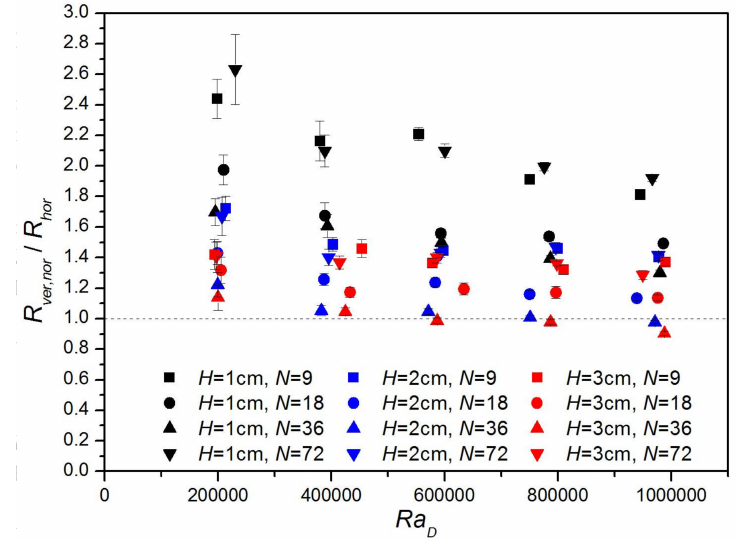
Figure 18. Ratios of thermal resistances of normal vertical cylinders with triangular fins to those of horizontal cylinders with triangular